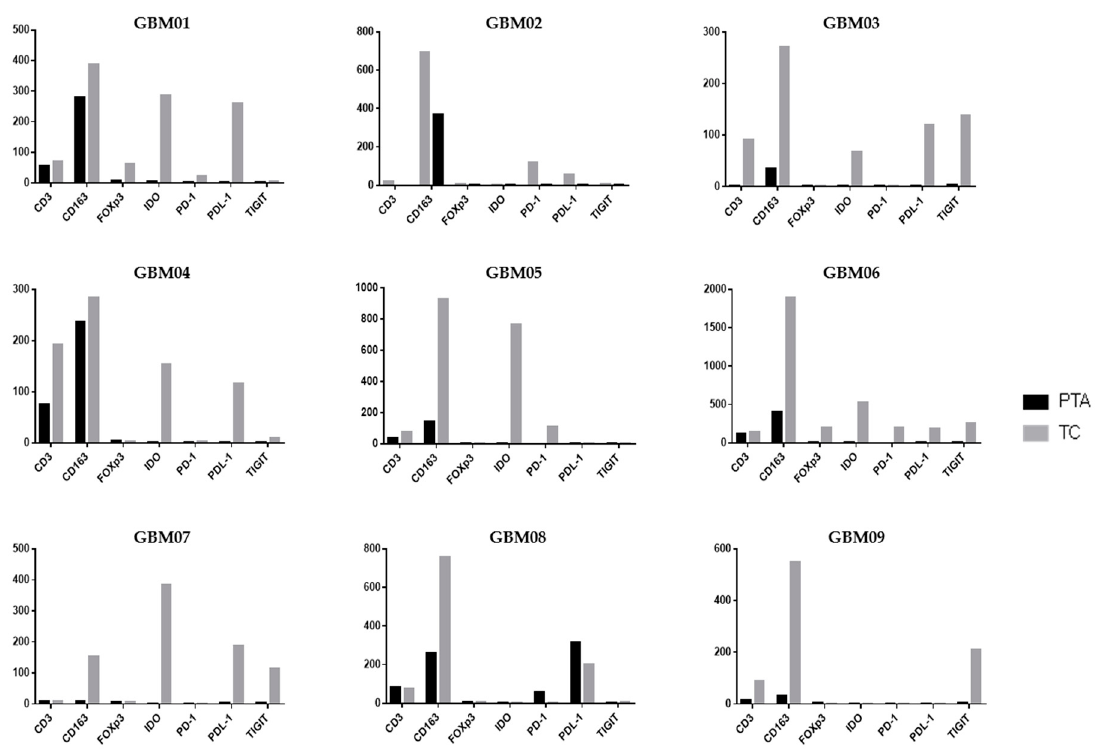
Figure 4. Immune cell profile in each GBM patient sample. IHC values for each immune marker are displayed for each GBM patient sample. Histograms represent the IHC values obtained with the ImageJ software and reported as arbitrary units ( y axis).